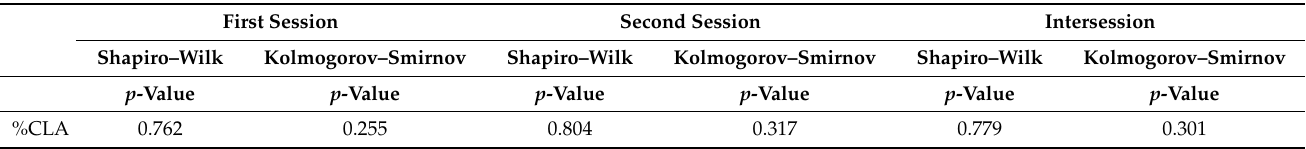
Table 1. Normality test of the variable percentage of the area of the pressure center in the population in the first session, second session and